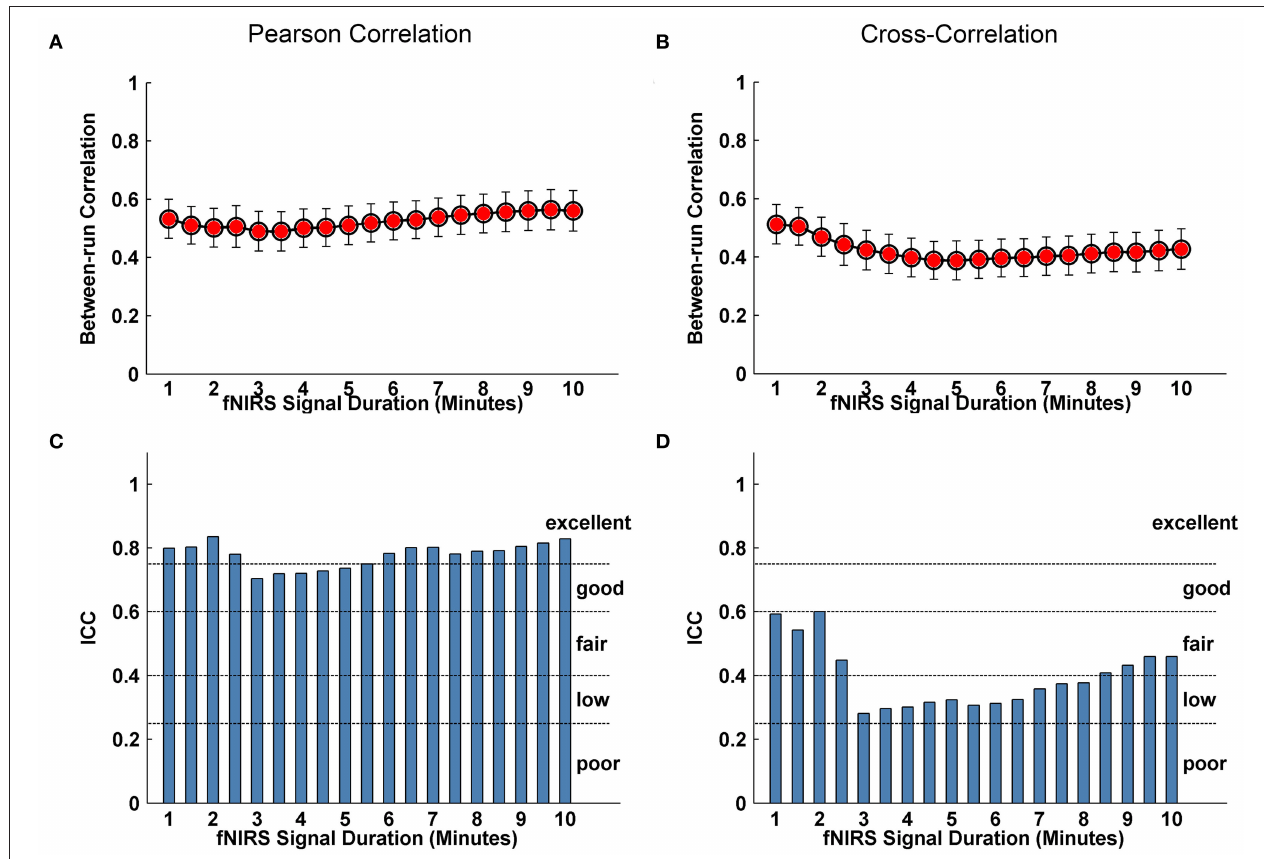
FIGURE 5 | Evaluation of the effect of fNIRS signal acquisition duration on the reproducibility of spatial FC patterns. (A,B) Between-run correlation coefficients for FC patterns plotted by duration of fNIRS signal acquisition (1.0 10.0 min in 30-s bins) at individual level. The red-filled circles indicate significant correlations in the spatial ∼ patterns of FC map in (A,C) and (B,D) calculated from Pearson correlation-derived and cross-correlation-derived networks,